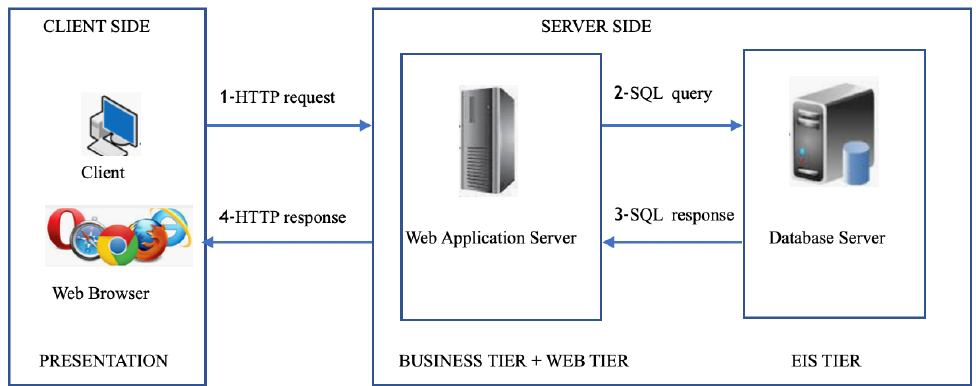
Figure 1. Overview of web